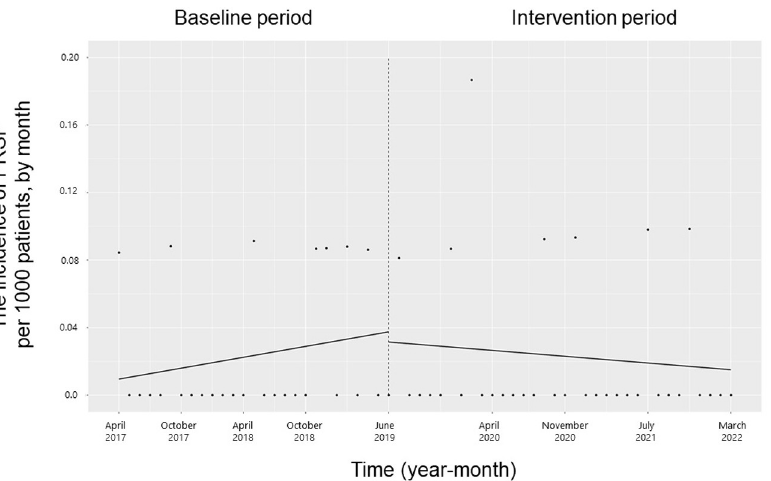
Fig 8. Trends in the incidence of penicillin-resistant Streptococcus pneumoniae (PRSP) per 1000 patients, by month, during the pre-intervention period (Phase 1) and interventional period (Phases 2–4). Each dot refers to the PRSP per 1000 patients in each month; the slope is based on linear regression in the four phases: Phase 1 (pre- intervention period from April 1, 2017, to May 31, 2019); Phase 2 (review of clinical pathways from June 1, 2019, to March 31, 2020); Phase 3 (establishing an infectious disease (ID) consultation service and implementing the antimicrobial stewardship program from April 1, 2020, to June 30, 2021); and Phase 4 (educational lecture and pop-up displays for oral antimicrobials from July 1, 2021, to March 31,